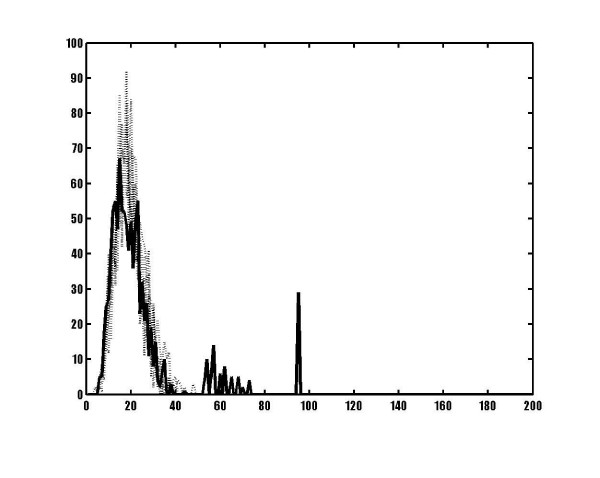
Histogram for non-coding presumed non-regulatory sequence. Distribution of similar words for a non-coding, non-regulatory sequence, randomly picked from chromosome 3L has significant tail because of simple repeats. The X axis shows the size of lists of similar words, the Y axis is the number of lists.